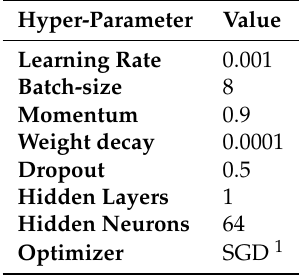
Table 3. Hyper-parameters values that achieved best